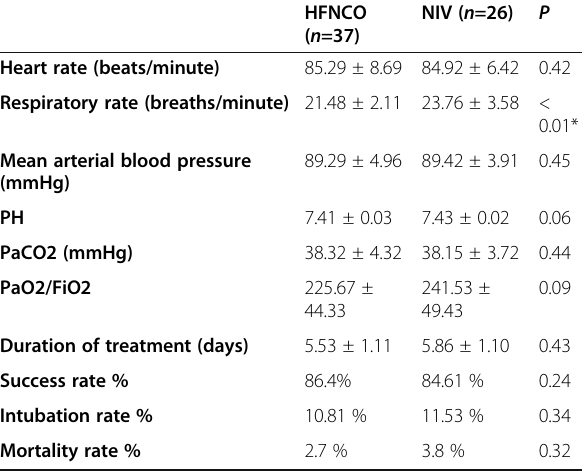
Table 5 Comparison between vital signs and arterial blood gases before and after treatment in patients receiving NIV